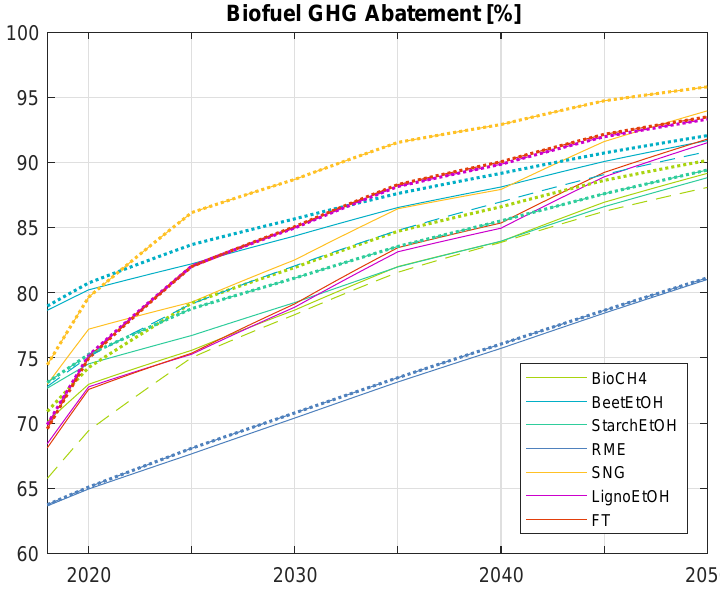
Figure 3. Biofuel GHG abatement development, compared on an energetic basis with the fossil reference. The solid lines show the development in Scenario (a), at a moderate power mix development; the dotted lines show the development in Scenario (b), at a more progressive power mix development; the dashed lines show the development in Scenario (c), with additionally lower sugar beet and silage maize yields. The non-smooth developments of some of the curves (of the options with a large power input) are due to interpolation of power mix values, which are given for every five